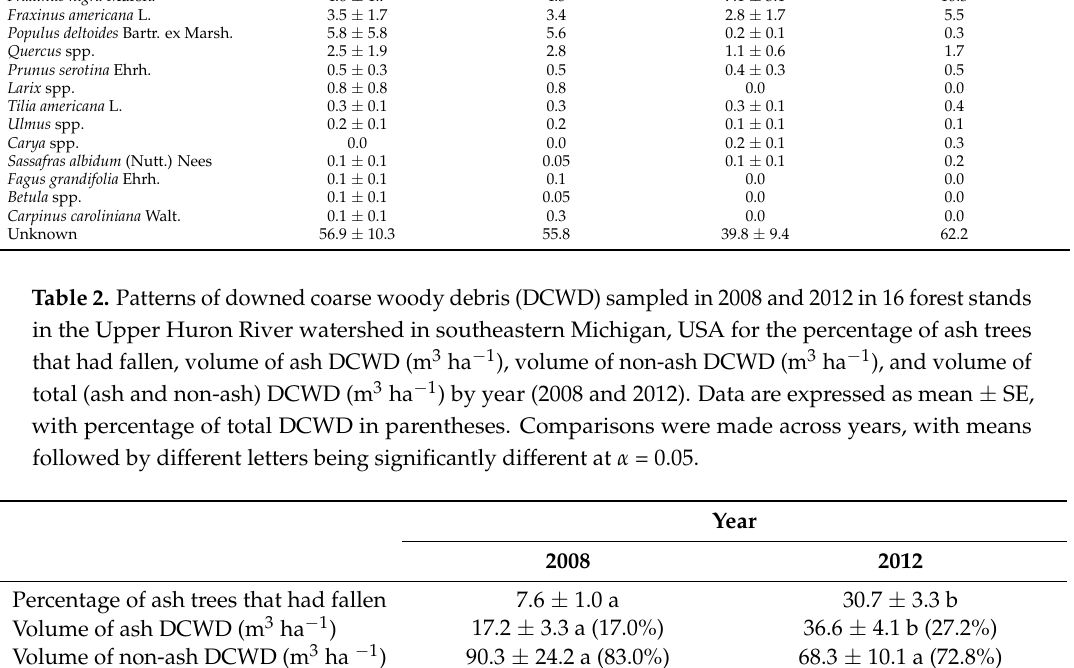
Table 1. Average ± SE volume (m 3 ha − 1 ) and percentage of downed coarse woody debris (DCWD) by tree species in 2008 and 2012 in 16 forest stands in the Upper Huron River watershed in southeastern Michigan, USA. Tree Species Volume (m 3 ha − 1 ) Percentage of Total DCWD Volume (m 3 ha − 1 ) Acer spp.